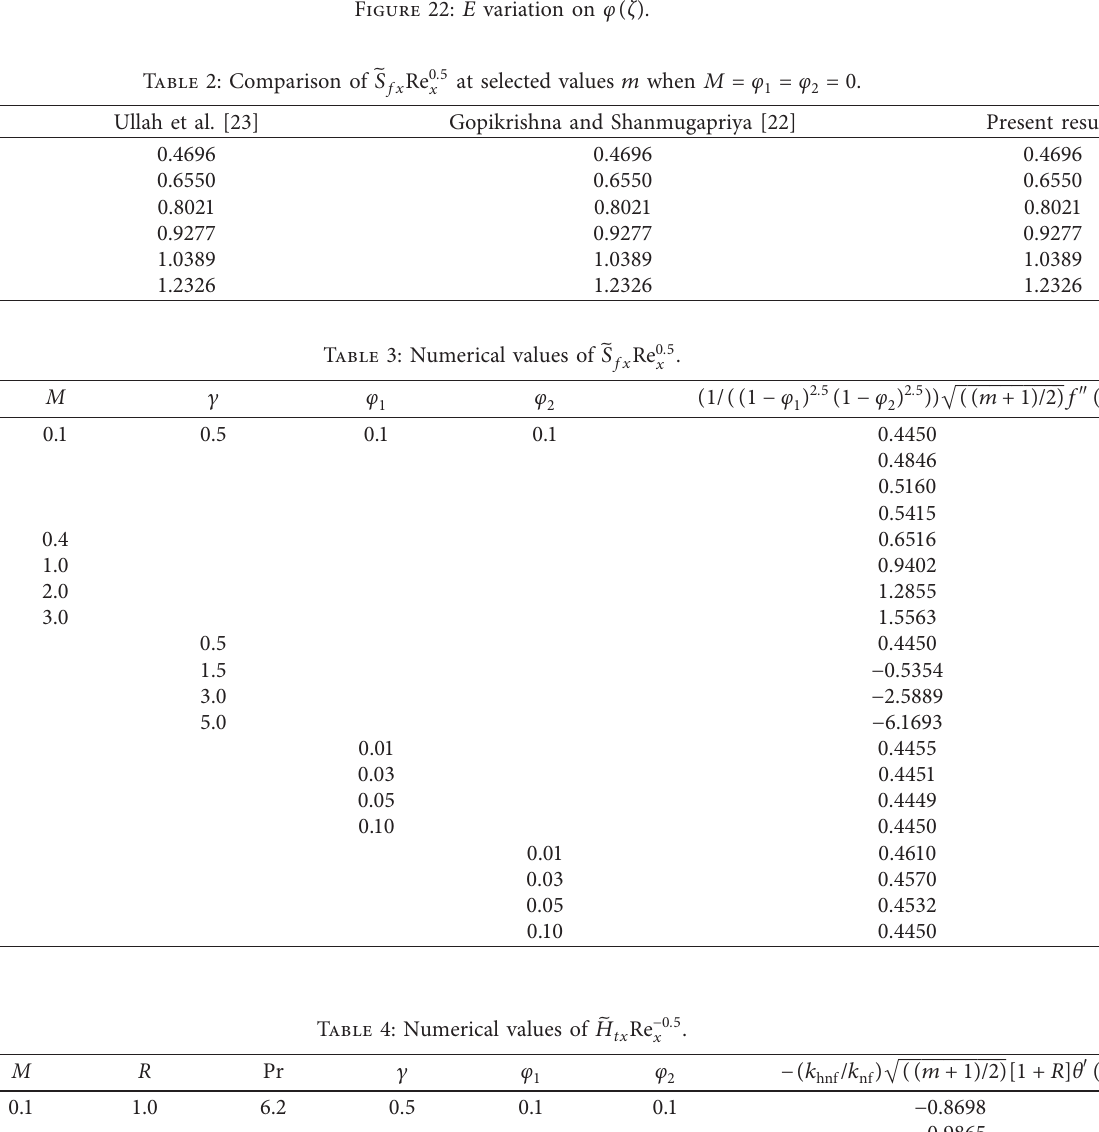
Table 2: Comparison of 􏽥 S